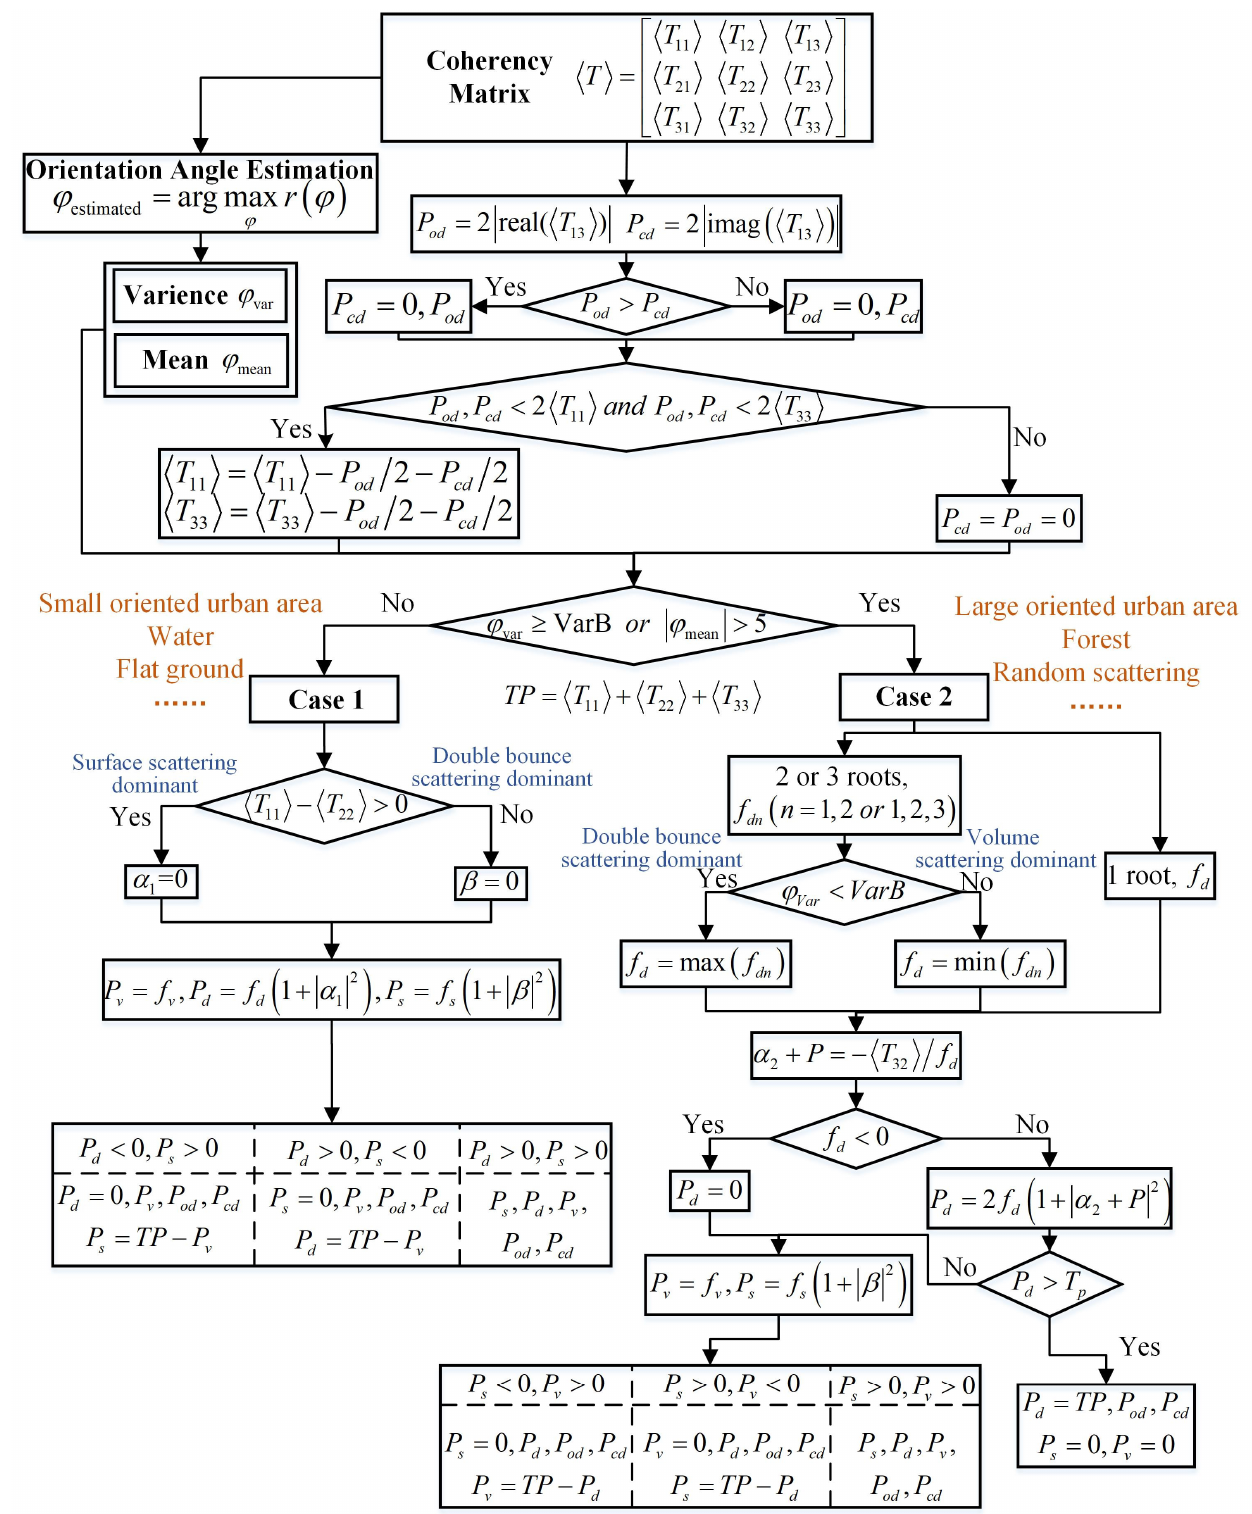
Figure 6. Flowchart of MRDM-5SD.